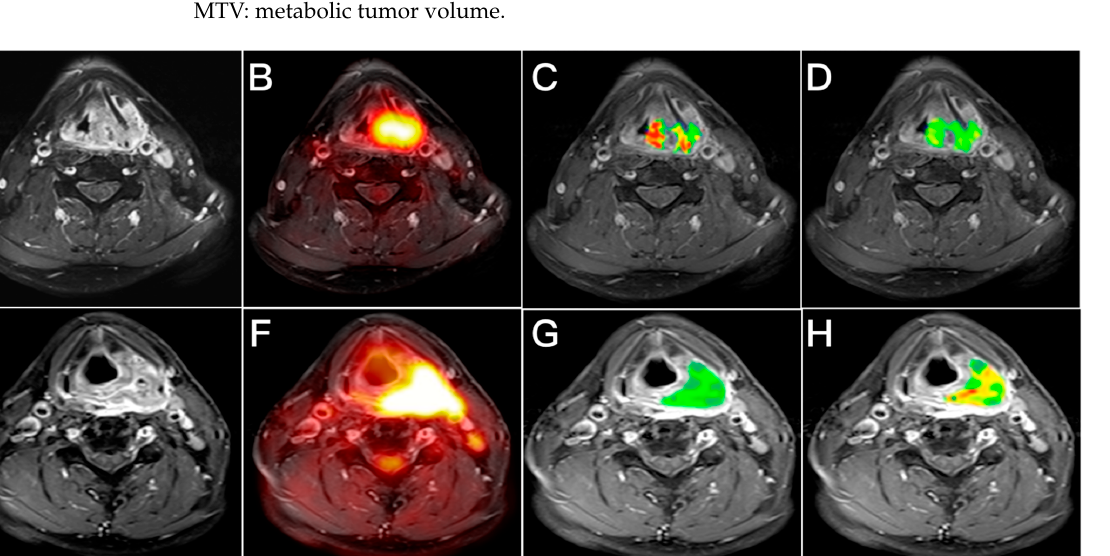
Figure 2. A combination of PET metabolic and IVIM functional biomarkers aided in predicting overall survival. ( A – C ) Representative axial images of a primary left tonsillar oropharyngeal cancer patient with T3N2b disease. ( A ) Contrast-enhanced MR image; ( B ) 18 F-FDG PET/MRI image; and ( C ) Contrast-enhanced MR image with an overlaid D* map of the primary tumor. This patient had a high MTV of 111 mL and a high D* value of 481 × 10 − 3 mm 2 /s. This patient died of tumor recurrence with a short overall survival period of 8 months after chemoradiotherapy. ( D – F ) Axial PET and MRI images of a primary tongue base oropharyngeal carcinoma patient with T3N2b disease. ( D ) Contrast-enhanced T1-weighted MR image; ( E ) 18 F-FDG PET/MRI image; and ( F ) Contrast-enhanced MR image with an overlaid D* map of the primary tumor. He had a low MTV of 58 mL and a low D* value of 255 × 10 − 3 mm 2 /s. He survived without disease recurrence for 4 years after chemoradiotherapy. MTV: metabolic tumor volume.